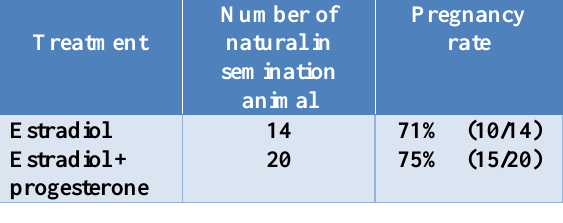
Table, 2: Effect of different treatment protocols on pregnancy rate in postpartum anestrous buffaloes (true